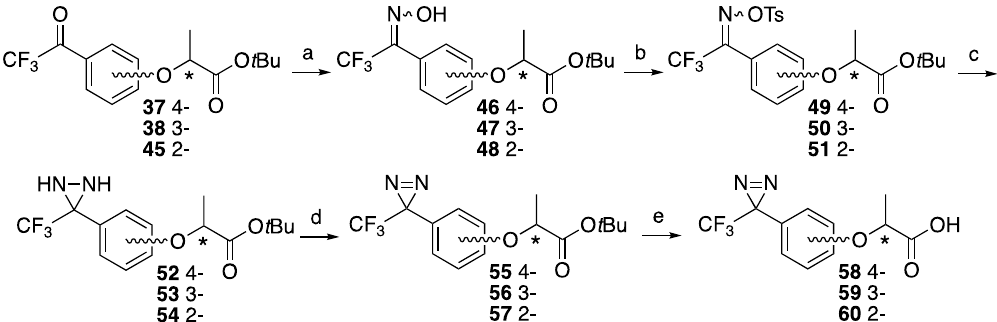
Figure 7. Synthesis of 2-, 3- and 4-trifluoromethyl diazirinyl lactisole derivatives. ( a ) NH 2 OH HCl,